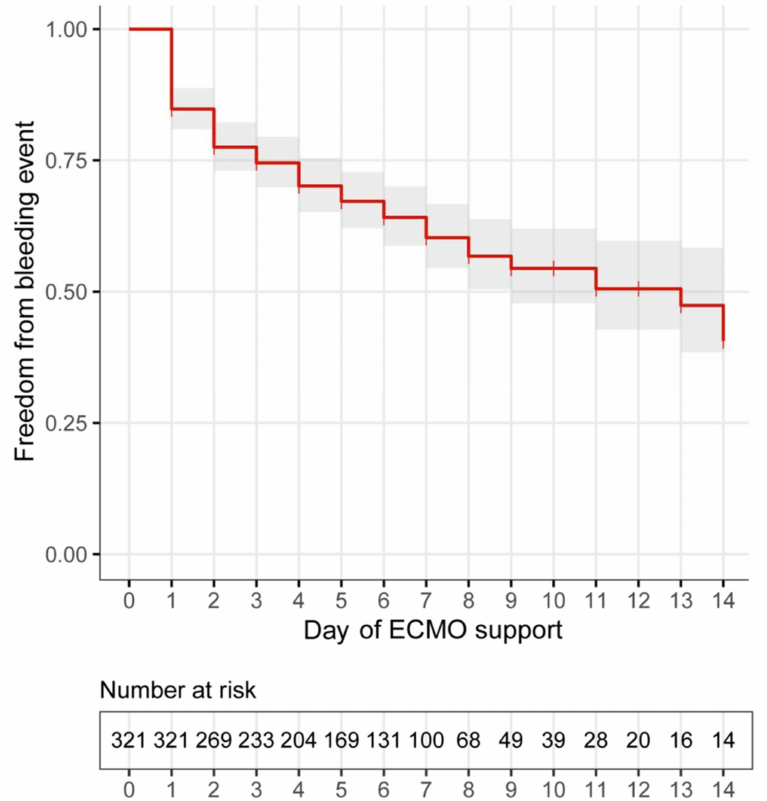
Figure 2. Kaplan-Meier curve: time from ECMO initiation to bleeding event ( n = 321, median estimate 13 days, 95% CI 9.3–16.7). ECMO: extracorporeal membrane